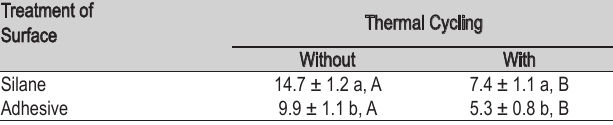
Table 1 - Mean shear bond strength values (S.D.) in MPa for treatment of surface, with and without thermal